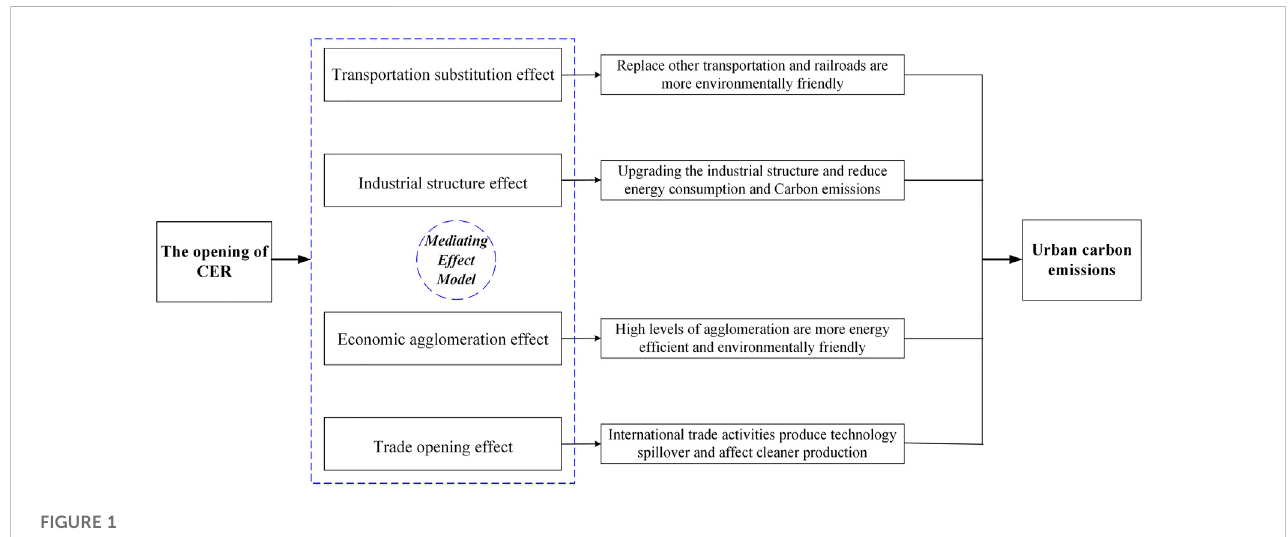
FIGURE 1 Mechanism